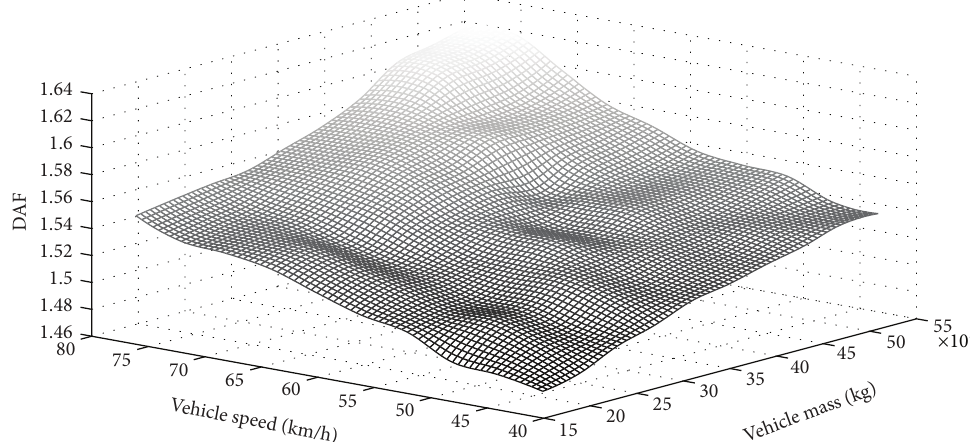
Figure 27: Dynamic amplification factor with change in vehicle speed and vehicle mass.